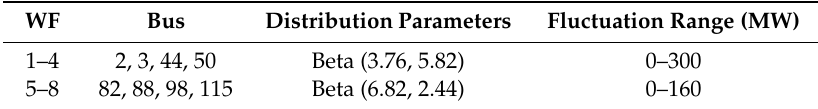
Table 5. Uncertainty descriptions of wind farms (IEEE-118).